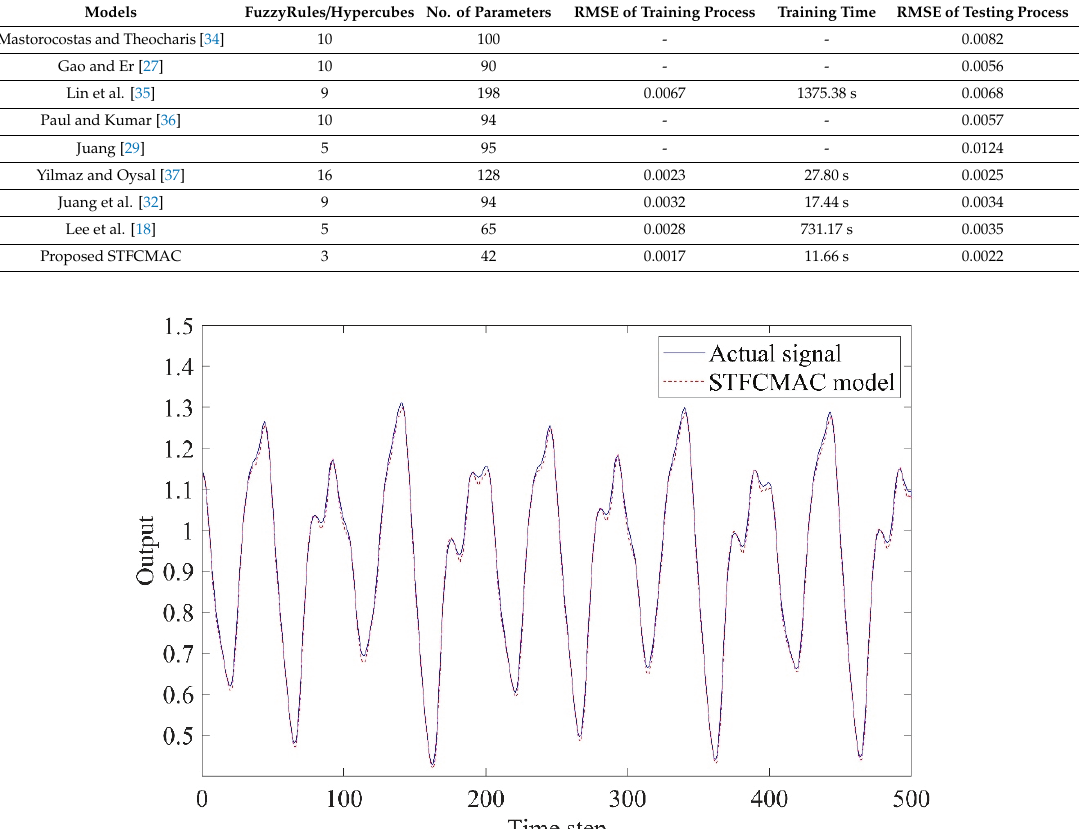
Figure 10. The results of chaotic time series prediction obtained using the STFCMAC model.